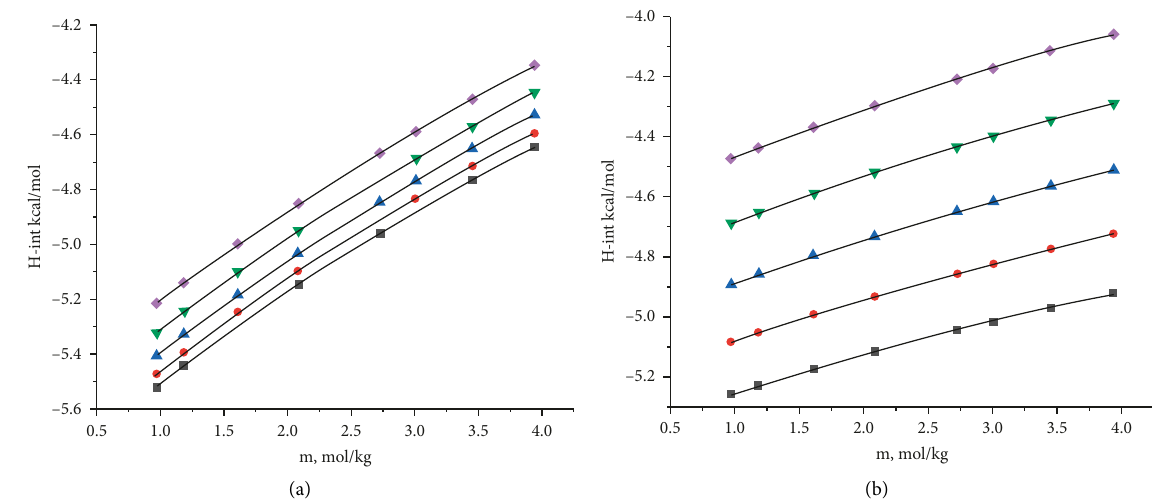
Figure 5: Correlation of the interaction data for the CaBr2+H2O system. (a) The interaction of CaBr2 and (b) the interaction of H2O. Symbols ( , T �